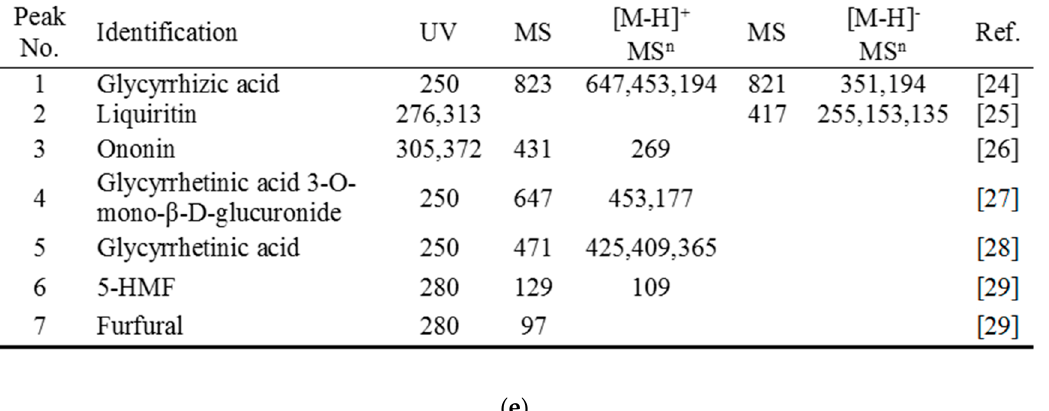
Figure 3. HPLC-ABTS· + chromatographic profiles and HPLC-MS/MS information regarding the extracts at different temperatures. ( a – d ) was the chromatographic profiles at 100, 140, 200 and 280 °C; ( e ) the HPLC-MS/MS information [24–29].